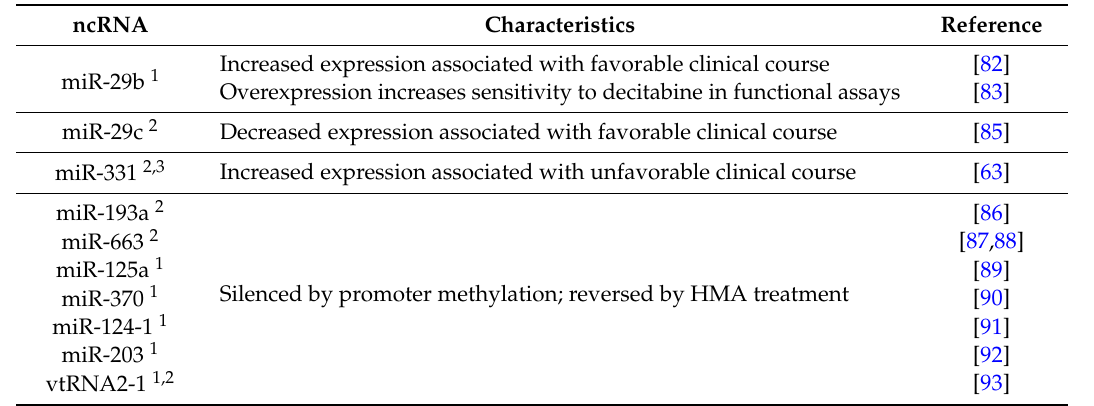
Table 2. ncRNAs linked to therapeutic resistance and sensitivity, respectively, to low intensity treatment regimens of